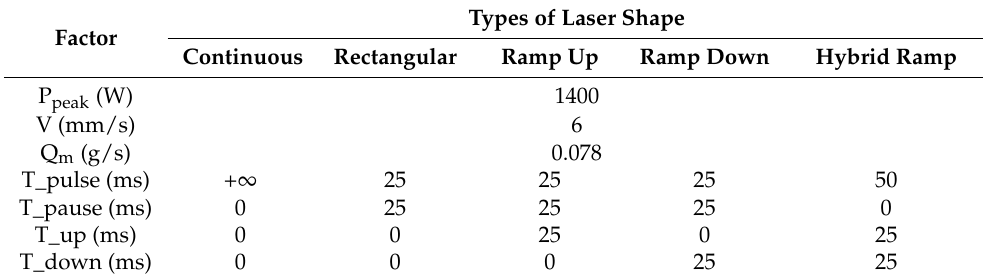
Table 2. Process parameters for